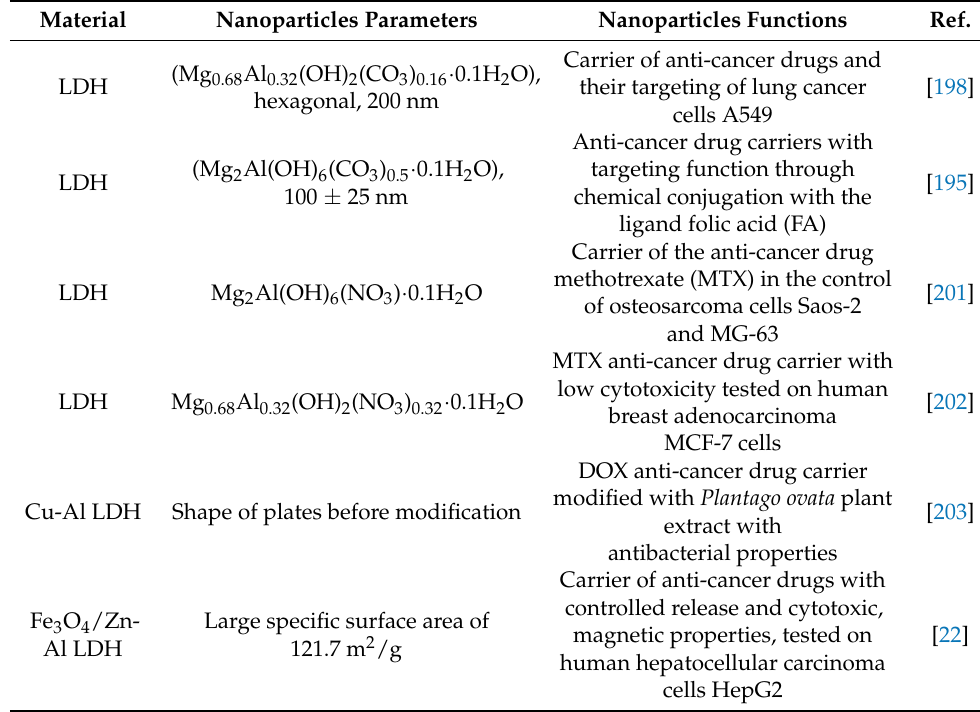
Table 3. Layered double hydroxides (LDH) used in anti-cancer therapies.